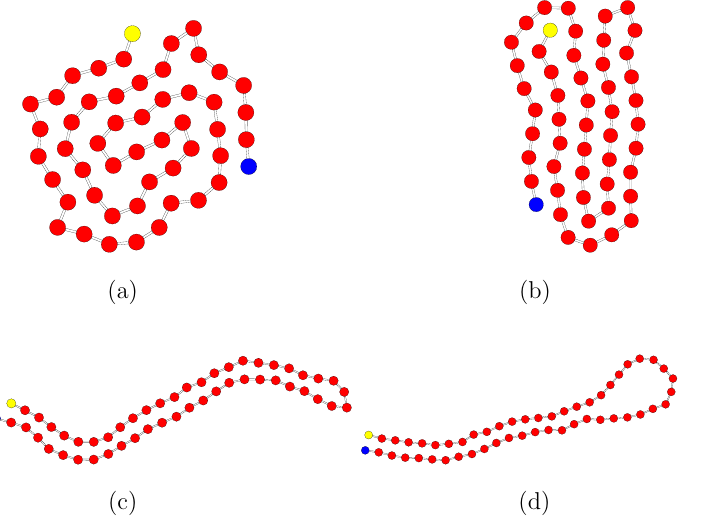
Figure 1. Equilibrium polymer conformations for L p / L = 0.1 ( a ), 0.2 ( b ), 0.4 ( c ), 0.8 ( d ) with (cid:101) / ( k B T ) = 2. Blue and yellow beads denote the first and last ones, respectively. Polymer beads and bonds are not in scale to allow a better